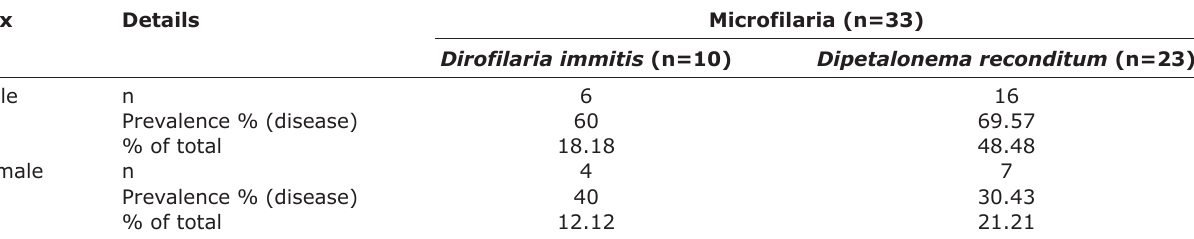
Table-4: Overall prevalence and distribution of microfilariae ( D. immitis and D. reconditum ) in male and female dogs from Gujarat state, India.